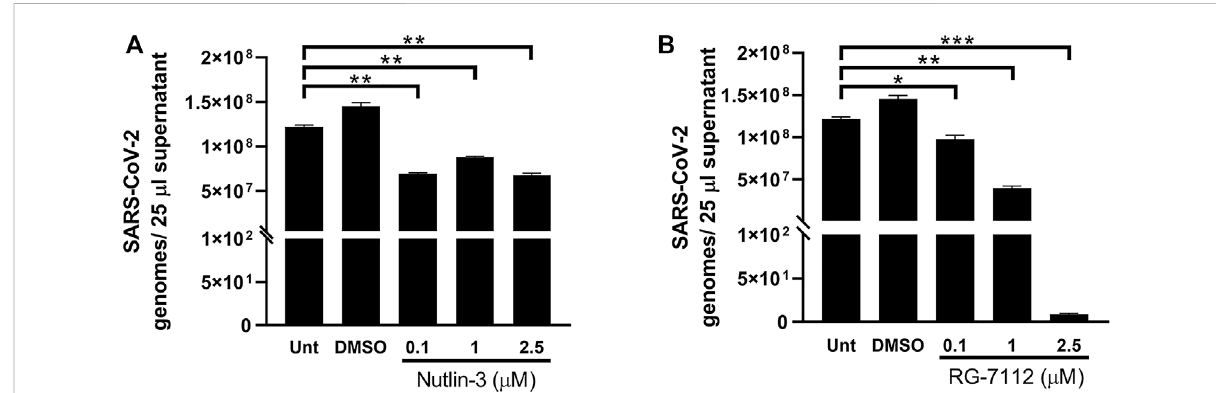
FIGURE 4 Quanti fi cation of SARS-CoV-2 infection. Quanti fi cation of SARS-CoV-2 genomes determined by RT-qPCR in 25 µL A549-hACE2 supernatants collected at48 hpost-infection ofcultures treatedwith differentconcentrationsof Nutlin-3 (A) orRG-7112 (B) and relativecontrols (Unt, untreated; DMSO, control vehicle). Results were plotted as mean ± standard error of the mean of two independent experiments run in triplicates. Statistical analysis was performed by Student ’ s t test. * p ≤ 0.05; ** p ≤ 0.01; *** p ≤